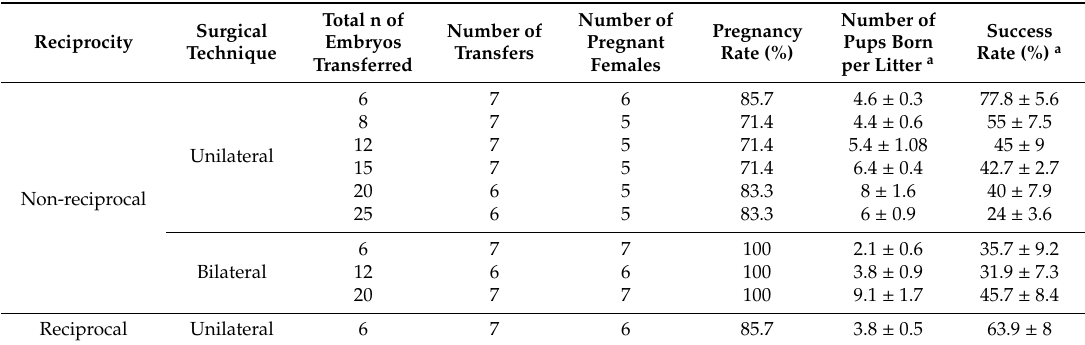
Table 2. C57BL / 6J transfer groups and